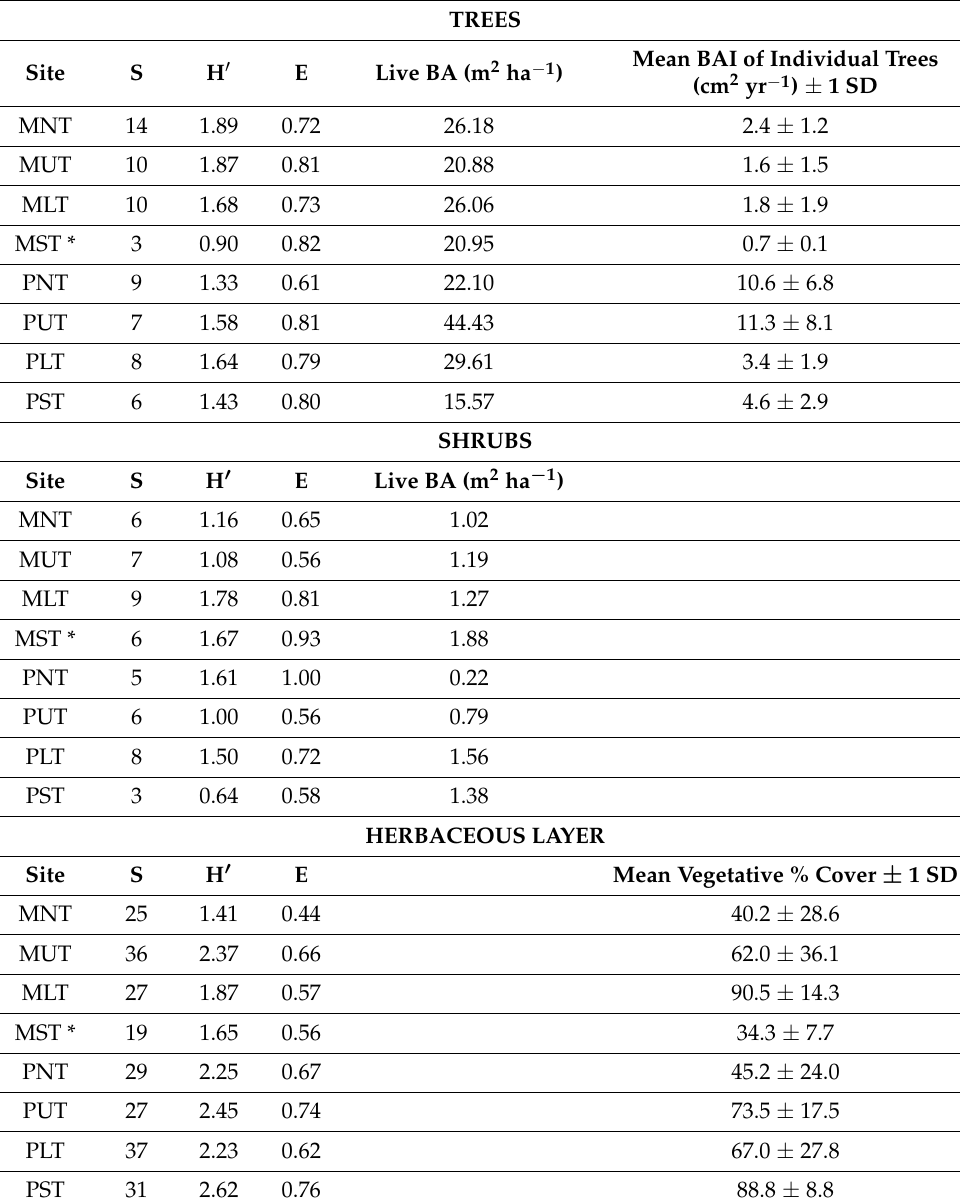
Table 1. Species richness (S), Shannon-Weiner diversity index (H (cid:48) ), Evenness (E), basal area (BA), basal area increment (BAI, 1979–2015), and mean herbaceous percent cover values for live canopy trees, understory woody species and herbaceous layer species at the study sites. The ‘*’ indicates only one 20 × 20 m plot for trees, two 5 × 5 m plots for shrubs and three 1 × 1 m herbaceous layer plots were installed and surveyed at site